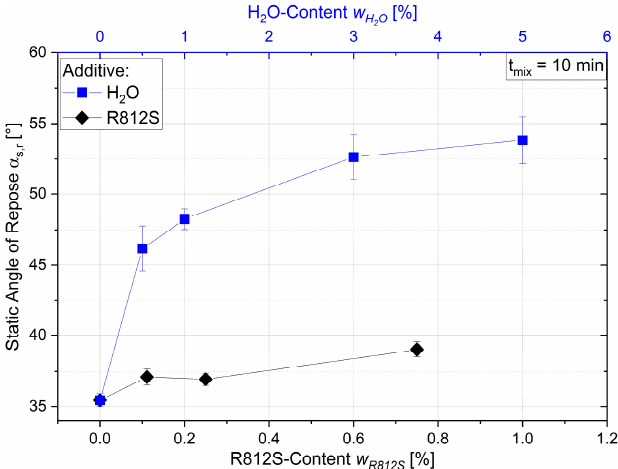
Figure 3. Static angle of repose as a function of the added mass fraction for mixtures with water and R812S.